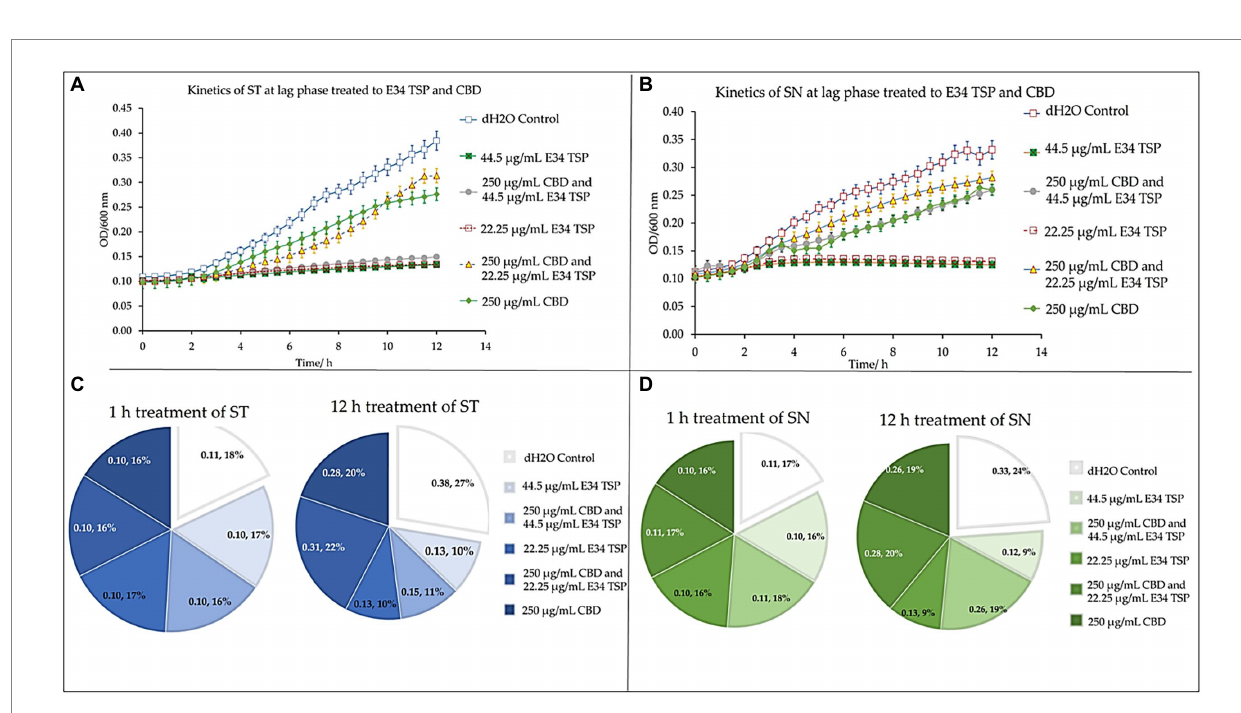
FIGURE 9 Kinetics of combined treatment of E34 TSP with CBD extract on (A) S . Typhimurium (ST) in the lag growth phase, (B) S . Newington (SN) in the lag growth phase. (C) Pie chart illustrating the relative percent changes in OD 600 of S . Typhimurium among treatments. (D) Pie chart illustrating the relative percent changes in OD 600 of S . Newington among treatments. Studies were initiated an initial OD 600 of approximately 0.1 Data shown are from three independent experiments expressed as means ± SEM.